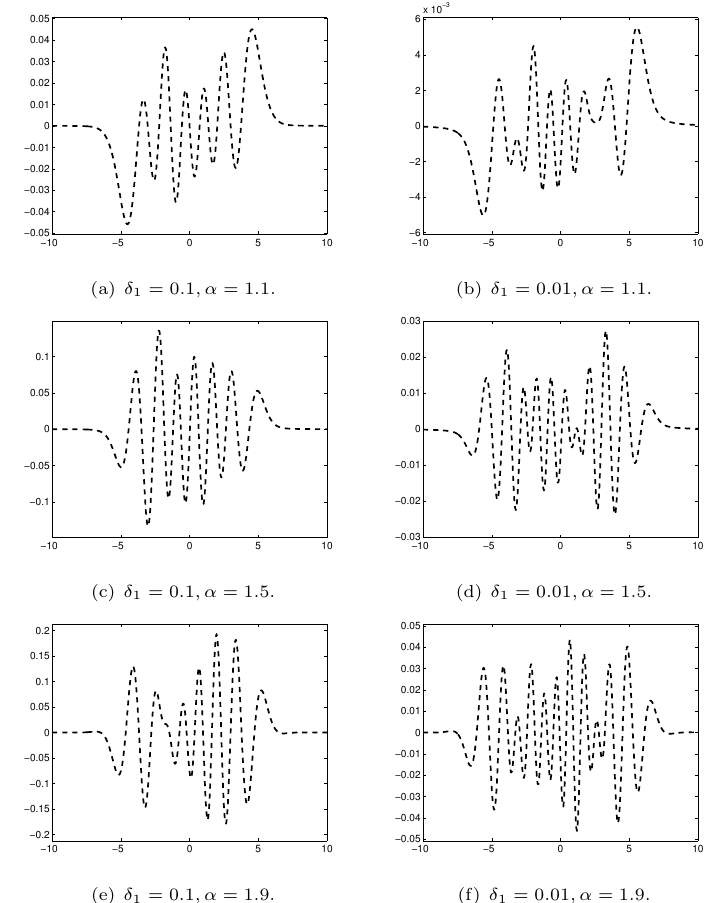
Figure 1. The error of the exact solution and its approximation (Example 1).